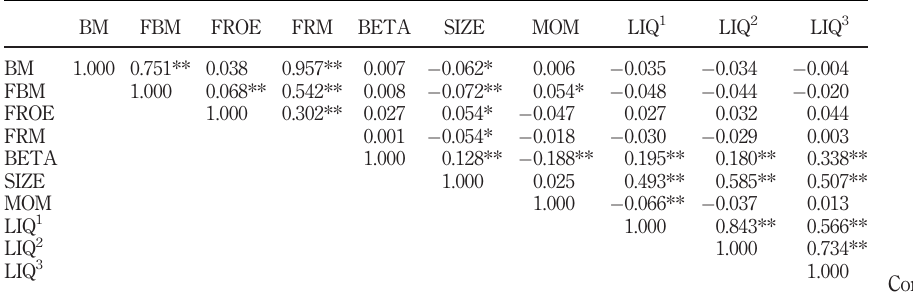
Table IV. Correlation matrix